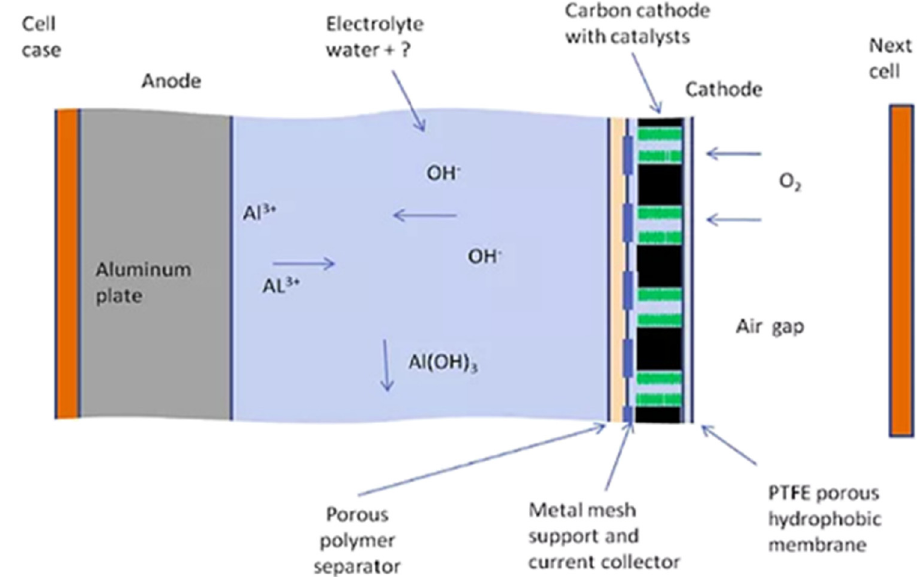
Figure 7: Schematic diagram of aluminum - air battery [ 16 ] .